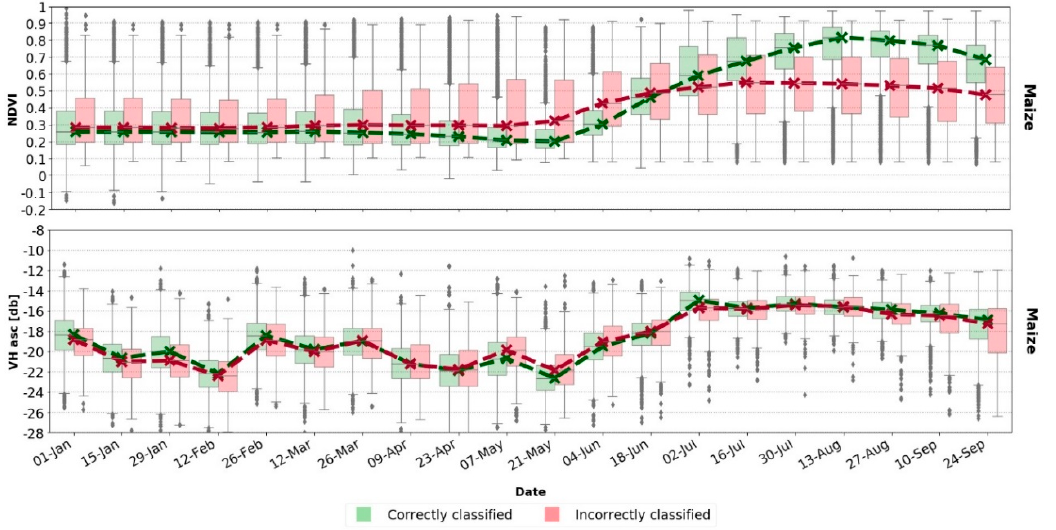
Figure 16. NDVI and VH temporal profiles of correctly classified and misclassified pixels of class maize.